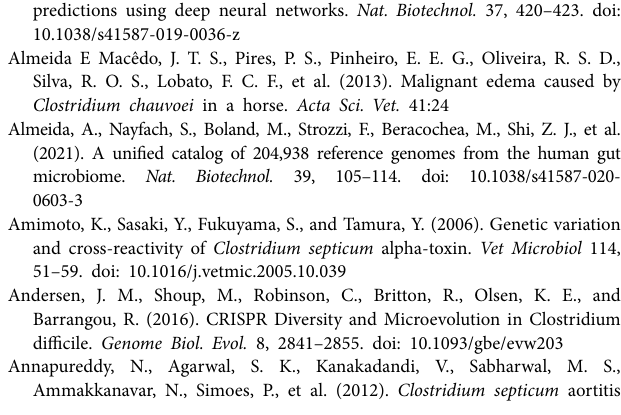
Supplementary Figure S1 | Taxonomic classification of C. septicum based on 16srRNA gene. The 16S rRNA gene based phylogenetic analysis of C. septicum indicates close relatedness with C. chauvoei within Clostridium genus cluster 1 ( Clostridium sensu stricto ). Supplementary Figure S2 | Diversity and structure of CRISPR regions and CRISPR spacers. CRISPR spacers present among strains are represented in the form of an array. (A) Every unique spacer present within any strain is represented with different color codes. (B) . Spacers that are shared among strains are represented with same color codes and unshared spacers are represented in gray. The three CRISPR regions in the type strain DSM 7534 T intervened by IS256 family transposons are indicated as white space. Supplementary Figure S3 | Clusters of Orthologous Groups (COGs) categorization of core and accessory genes. Functional annotation of the core and accessory genes were carried out for COGs. Most of the accessory were belonging to the category of representing function unknown (S) and replication, recombination and repair (L). Supplementary Figure S4 | Phylogenetic tree involving C. septicum alpha toxin cds at nucleotide level. Phylogenetic relatedness of alpha toxin gene (full CDS) among C. speticum strains from diverse host/source and geographical sources was inferred. Supplementary Figure S5 | Protein alignment of Clostridium septicum virulence factors. Alignment of primary virulence factors showing amino acid variations are shown in Figure S5. (A) Alpha toxin, (B) Sialidase, (C) Hemolysin A, (D) , Hyaluronidase NagJ and (E) Hyaluronidase NagH. Supplementary Table S1 | Metadata summary of sequences retrieved from NCBI. Details with respect to species, strain name, and NCBI accession numbers of species of Clostridium sensu stricto used for 16S rRNA phylogenetic analysis are shown. Supplementary Table S2 | Taxonomic classification of C. septicum based on in silico DNA-DNA hybridization. Supplementary Table S3 | Prophages identified in C. septicum genomes. The prophages identified in five C. septicum strains indicating the size in bases, score predictions based on PHASTER, protein coding genes and BLAST identity are given. Supplementary Table S4 | KEGG pathway modules identified in the core genome of C. septicum . Supplementary Table S5 | Predicted B-cell epitopes in C. chauvoei toxin A (CctA) and in the identified homolog, C. septicum toxin A (CstA) identified by ABCpred